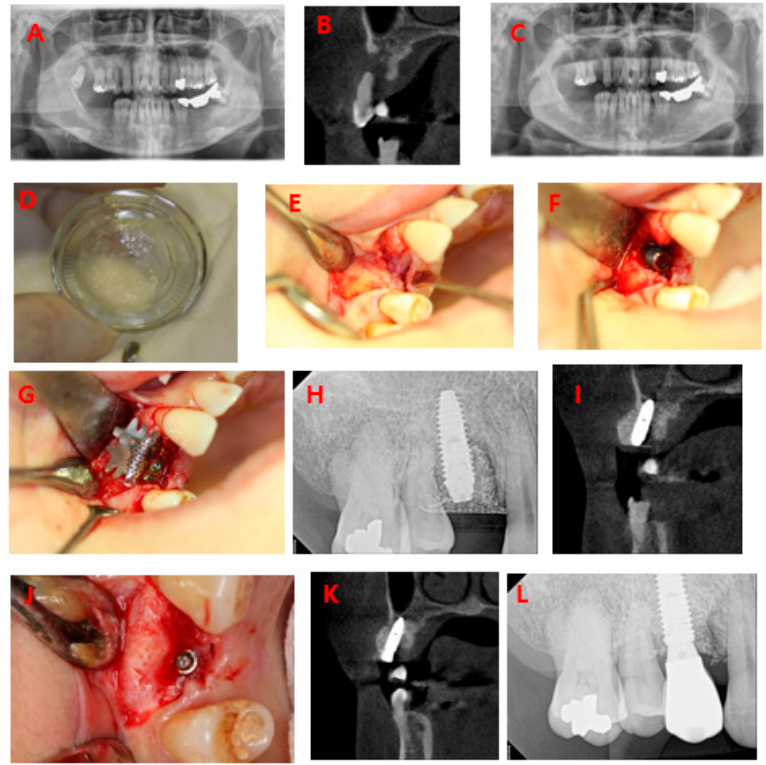
Figure 9. GBR case using AutoBT BMP. ( A ) Initial panoramic radiograph; ( B ) Initial CT view: severe alveolar bone resorption in the region of 14; ( C ) Panoramic radiograph after tooth extraction; ( D ) AutoBT; ( E – G ): First surgery in the region of 14; ( E ): Mucoperiosteal flap elevation; ( F ): Implant insertion and bone graft; ( G ) Titanium mesh covering; ( H ): Periapical radiograph after implantation; ( I ) CT view after implantation; ( J ) Second surgery; ( K ) CT view after second surgery; ( L ) Periapical radiograph after prosthetic loading.